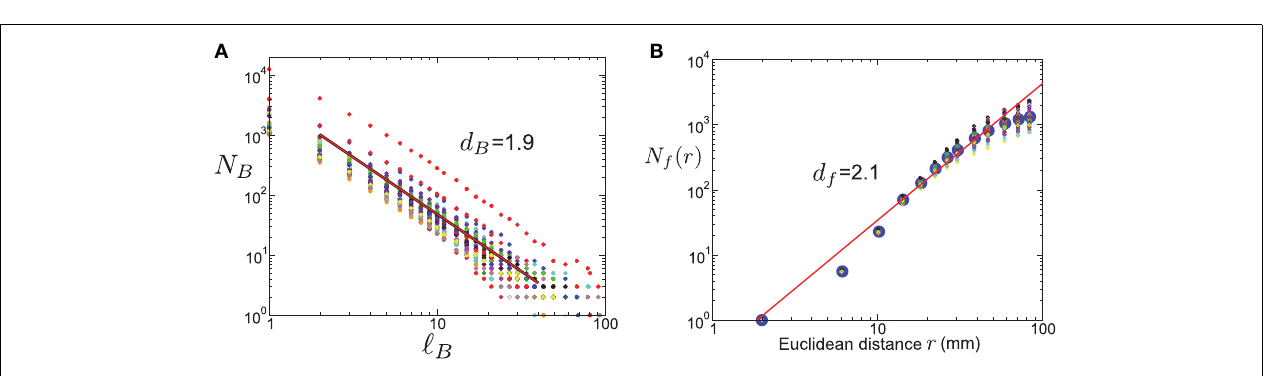
nodes N f ( r ) included within a fixed distance r , averaged over all clusters, while smaller points refer to individual clusters.The fitted line corresponds to the average dimension d f =